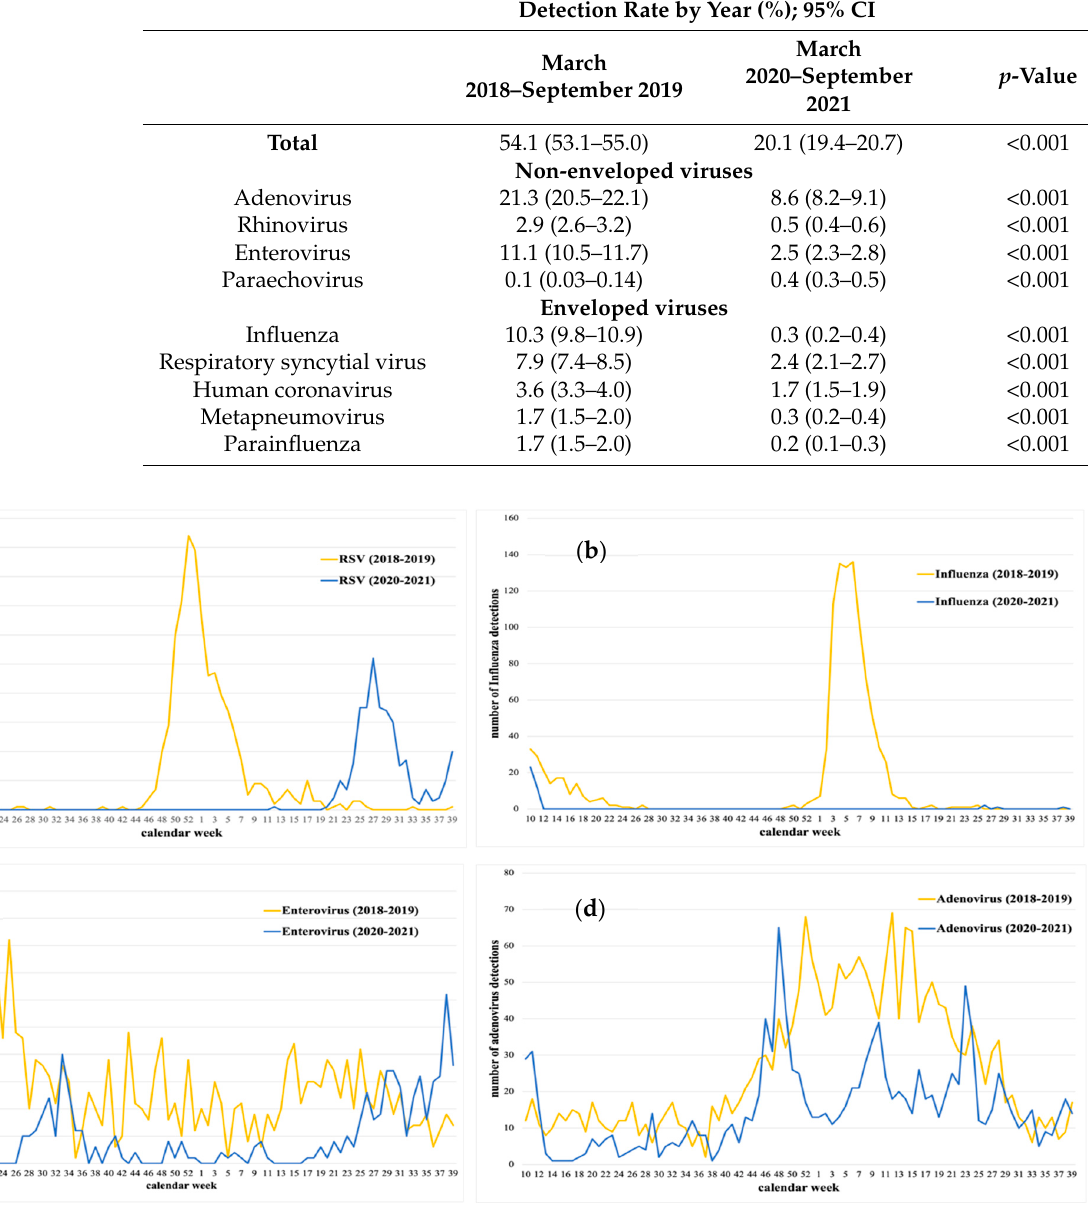
Table 1. Comparison of the detection rate of eight respiratory viruses between the periods 2018–2019 and 2020–2021.